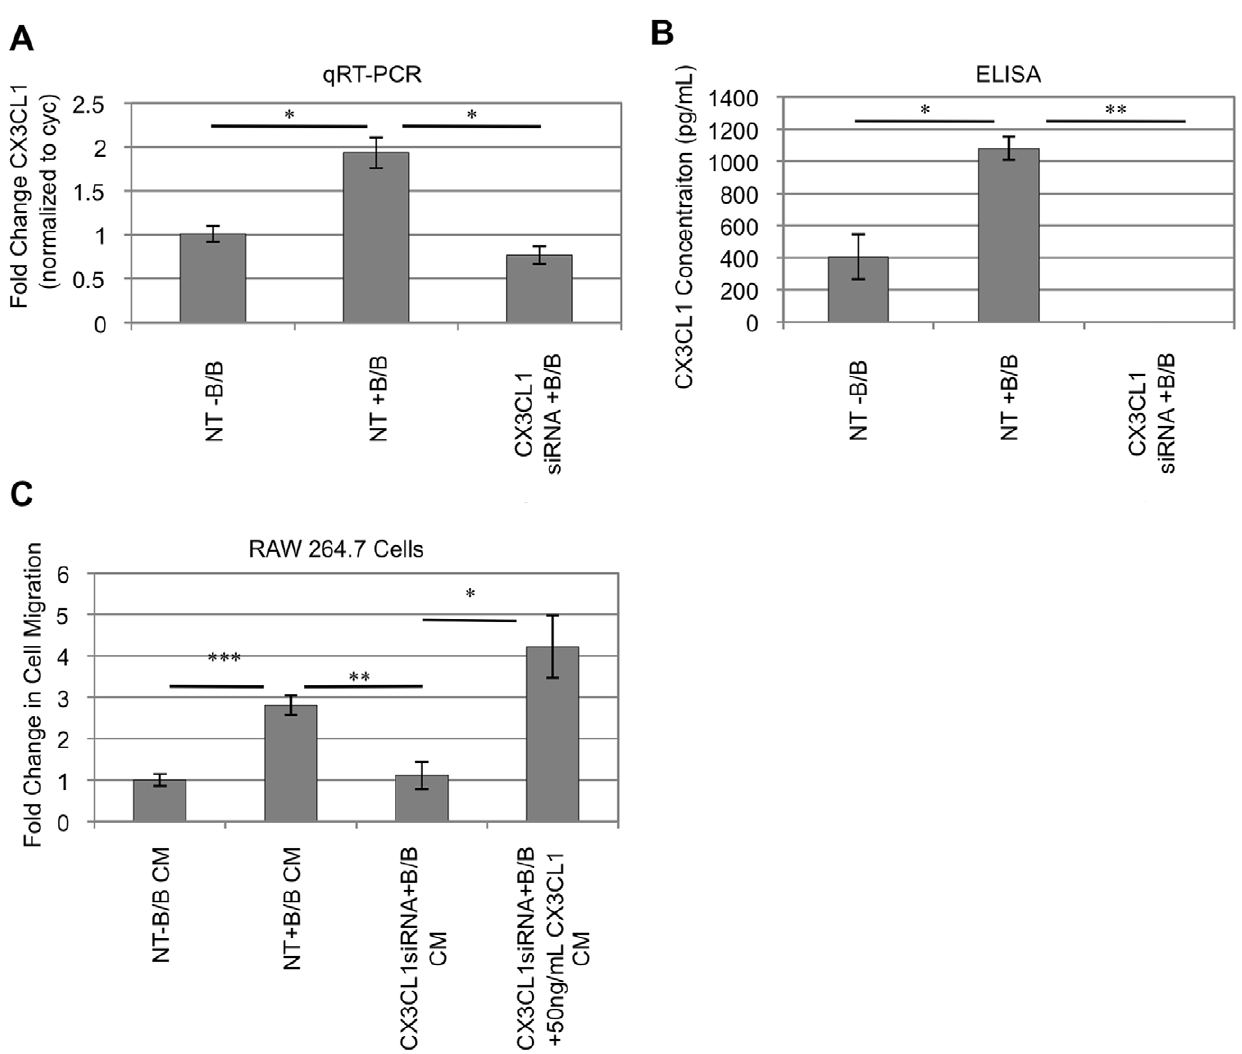
Figure 3. iFGFR1-induced CX3CL1 secretion by epithelial cells mediates macrophage migration. siRNA techniques were used to directly target CX3CL1 in order to determine the role of CX3CL1 in iFGFR1-mediated macrophage recruitment. A) CX3CL1 gene expression levels were significantly elevated in HC-11/R1 cells transfected with non-targeting (NT) siRNA. In comparison, CX3CL1 gene expression levels were significantly reduced in CX3CL1siRNA HC-11/R1 cells treated with B/B after 24 hours. B) ELISA was performed to verify reduction in CX3CL1 protein secretion in HC-11/R1 cells transfected with CX3CL1siRNA. Results indicated that soluble CX3CL1 protein concentrations were significantly induced in HC-11/R1 cells transfected with non-targeting (NT) siRNA. In comparison, soluble protein concentrations were reduced in CX3CL1siRNA HC-11/R1 cells treated with B/B after 24 hours. C) Conditioned medium from non-targeting HC-11/R1 cells treated with B/B significantly increased migration of RAW 264.7 cells relative to conditioned medium from cells treated with solvent alone. Exposure to conditioned medium from CX3CL1 siRNA HC-11/R1 cells significantly decreased RAW 264.7 cell migration. Furthermore, addition of 50ng/mL rmCX3CL1 to CX3CL1siRNA HC-11/R1 cells at the time of B/B treatment rescued the loss of RAW 264.7 cell migration in cells exposed to conditioned medium from CX3CL1siRNA HC-11/R1 cells. These results indicate that CX3CL1 is a key mediator of macrophage recruitment. *p , 0.05, **p , 0.001, ***p , 0.0001. Results in each figure panel are representative of a minimum of three different experiments. Error bars represent